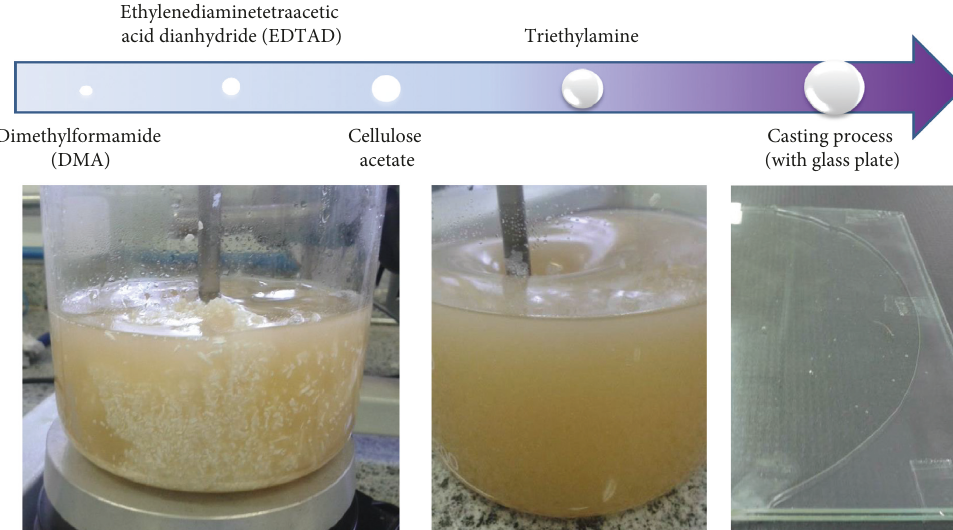
Figure 1: Synthesis of HAC-EDTA. Cellulose acetate and EDTAD are dissolved in DMF, then the catalyst is added, and the synthesis is finalized by the casting process.